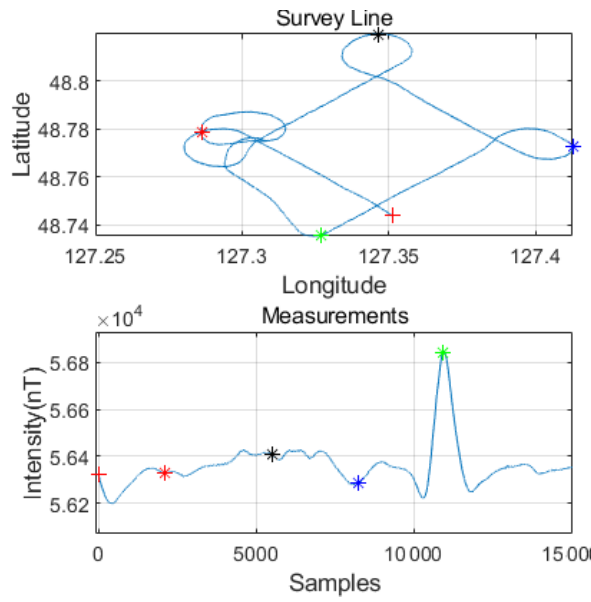
Figure 3. Diamond line and data.